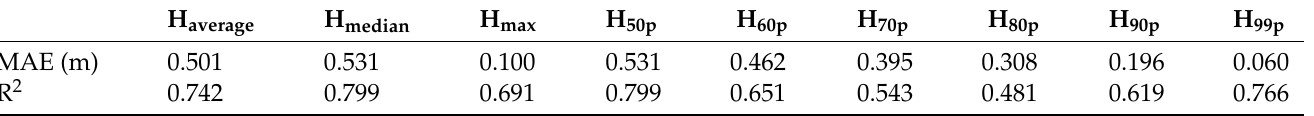
Table 3. Comparisons between canopy height derived from images and average canopy height manually measured in the field. H average : average canopy height. H median : median canopy height. H max : maximum canopy height. H np : n-th percentile canopy height MAE: mean absolute error. R 2 : coefficient of determination using linear